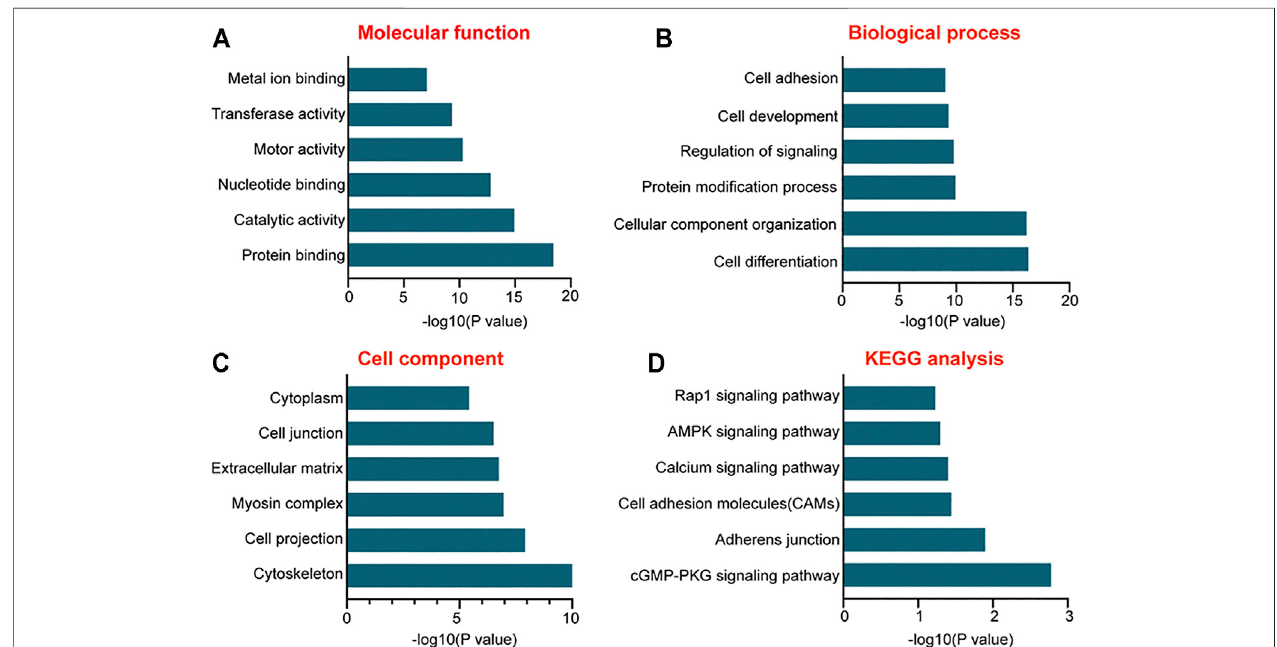
FIGURE3| Gene Ontology (GO)and Kyoto Encyclopedia ofGenesand Genomes (KEGG) pathway analysisoftheputative target genesofdifferentially expressed miRNAs. (A – C) ThefunctionsoftheputativetargetgenesofdifferentiallyexpressedmiRNAsinEPCsusingGOanalysis.TheGOenrichmentwasdividedintothreeparts: molecular function (A) , biologic process (B) , and cellular component (C,D) The bar plot shows the results of KEGG pathway analysis and reveals the top six signaling pathways involved in miRNA-mediated regulatory network.